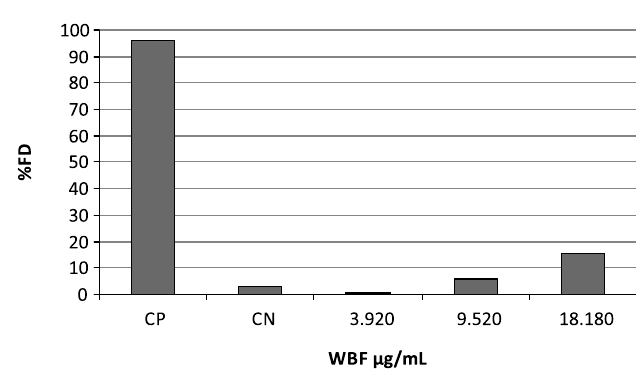
FIGURE 1 - Frequency of damage (FD) to DNA of human lymphocytes treated with different concentrations of WBF.